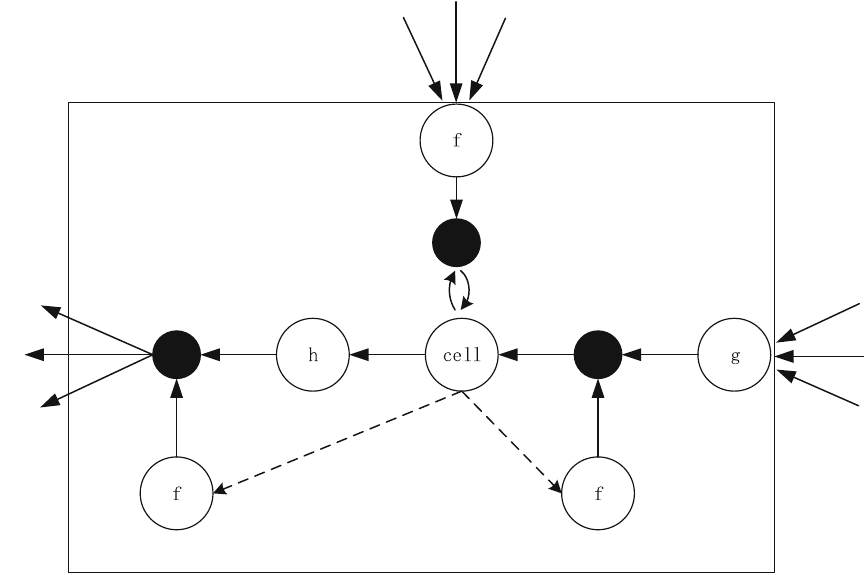
Fig. 2 LSTM neuron